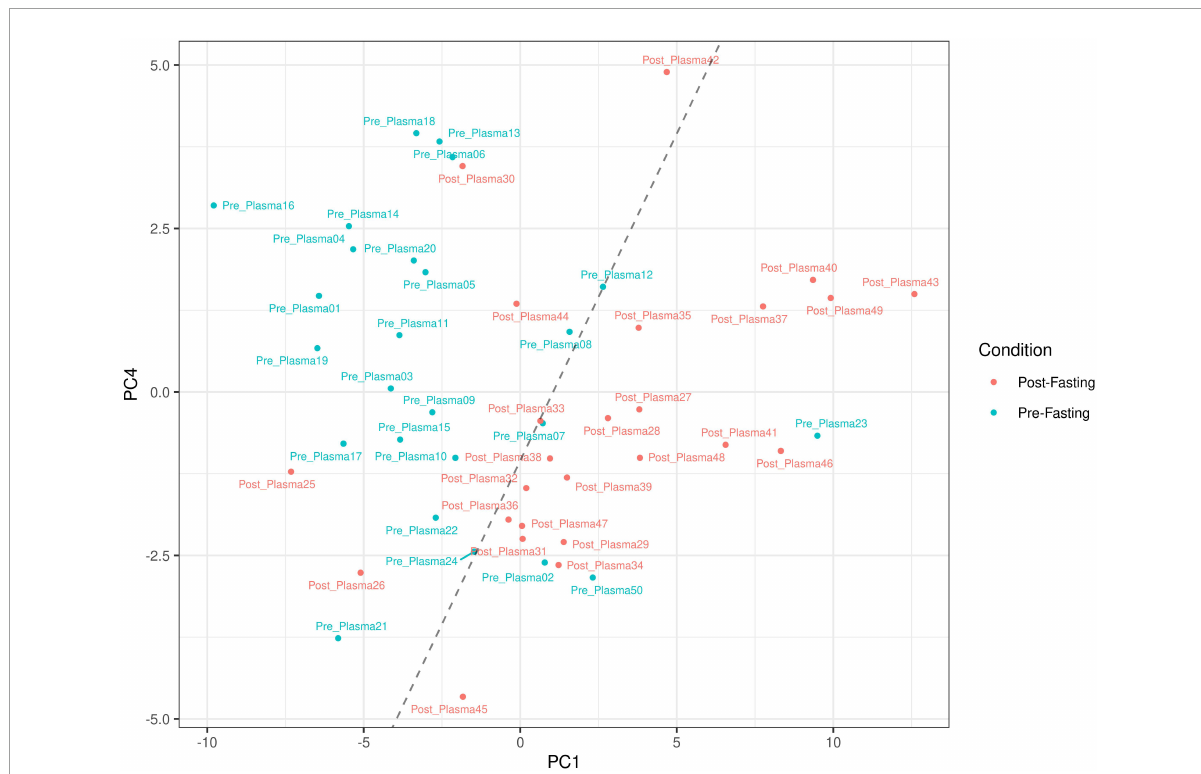
FIGURE1 Principal component analysis based on the metabolic profile measured in 50 blood plasma samples before and after intermittent fasting. Plots show sample clustering with blue and red dots indicating samples pre- and post-fasting. The dashed line is a visual aid to assist in visualizing the separation between the groups along the first and fourth principal components (PC1 and